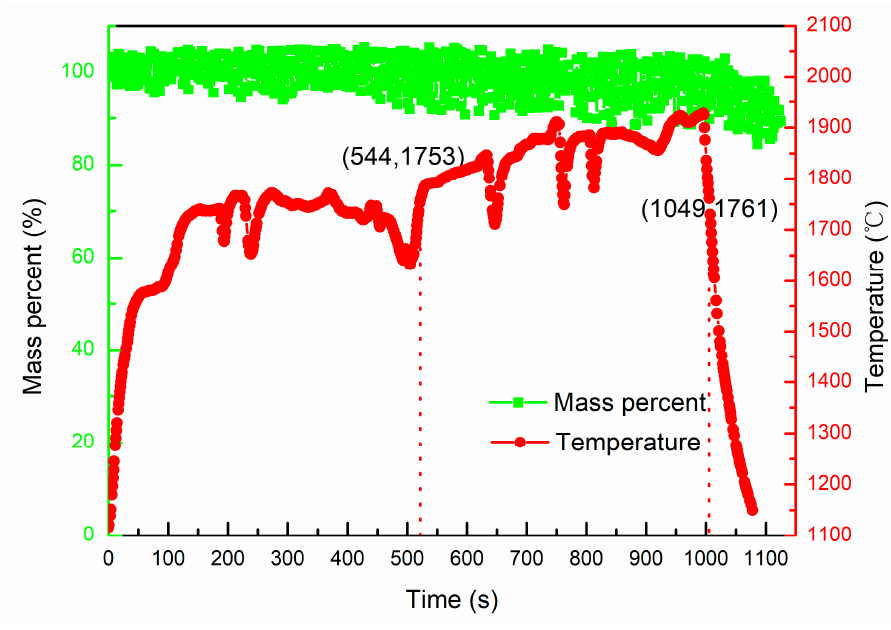
Figure 5. The vacuum evaporation of Al in Ti-Al alloy by EBM.